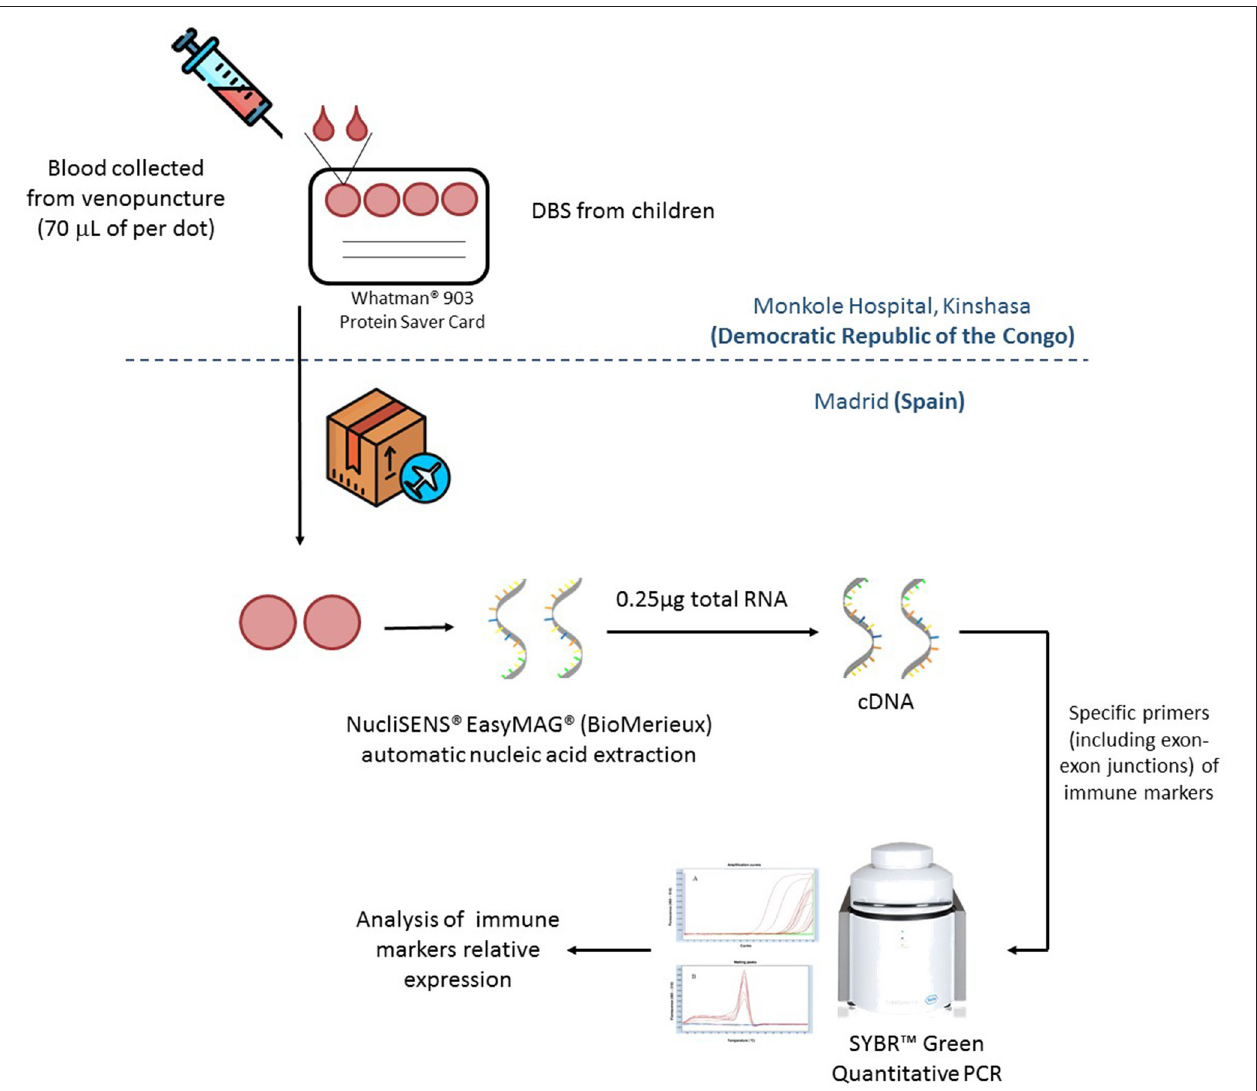
FIGURE 1 | Dried blood spots (DBS) samples from Kinshasa Hospital were send to Madrid in dried ice for their analysis. Once in Madrid, nucleic acids were extracted using two spots (70 µ l of dried blood per spot) per patient by NucliSENS ® EasyMAG ® (BioMerieux). Total mRNA was quantified by Nanodrop and 0.25 µ g of total RNA was retrotranscribed to complementary DNA (cDNA) by using High-Capacity cDNA Reverse Transcription Kit (Applied Biosystems). Relative expression of immune markers was quantified by qRT-PCR in a LightCycler ® 480